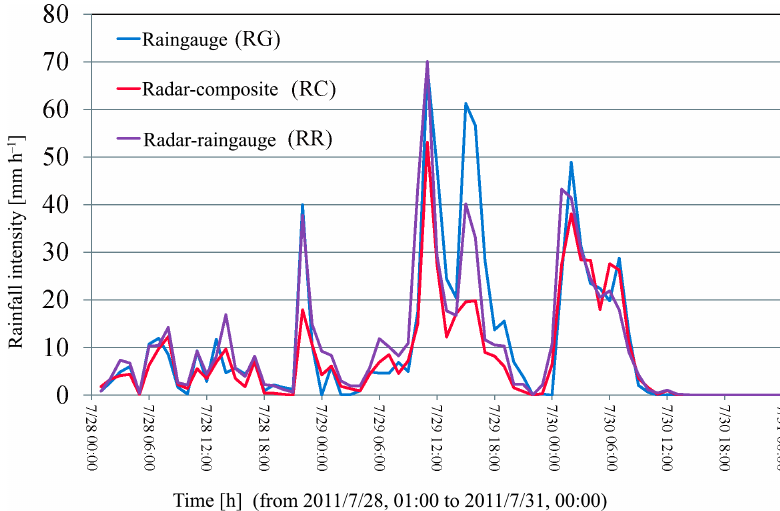
Figure 4. Catchment-averaged rainfalls of the Kasahori dam catchment.